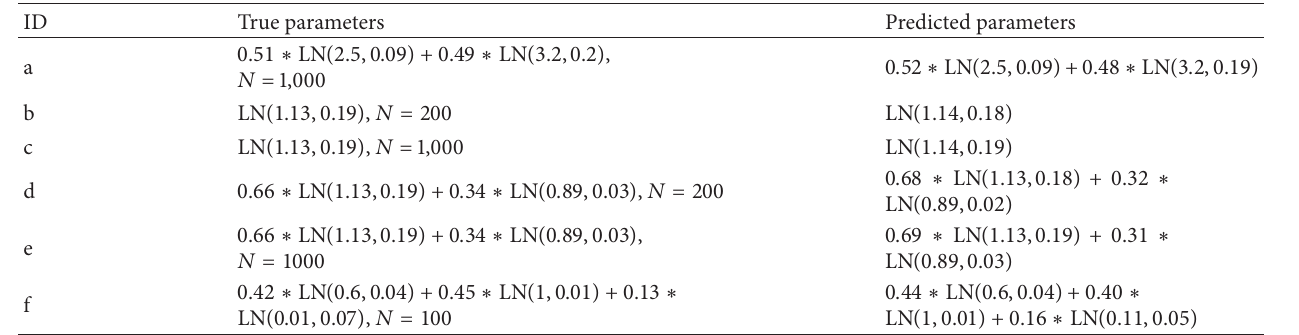
Table 3: Parameters of the